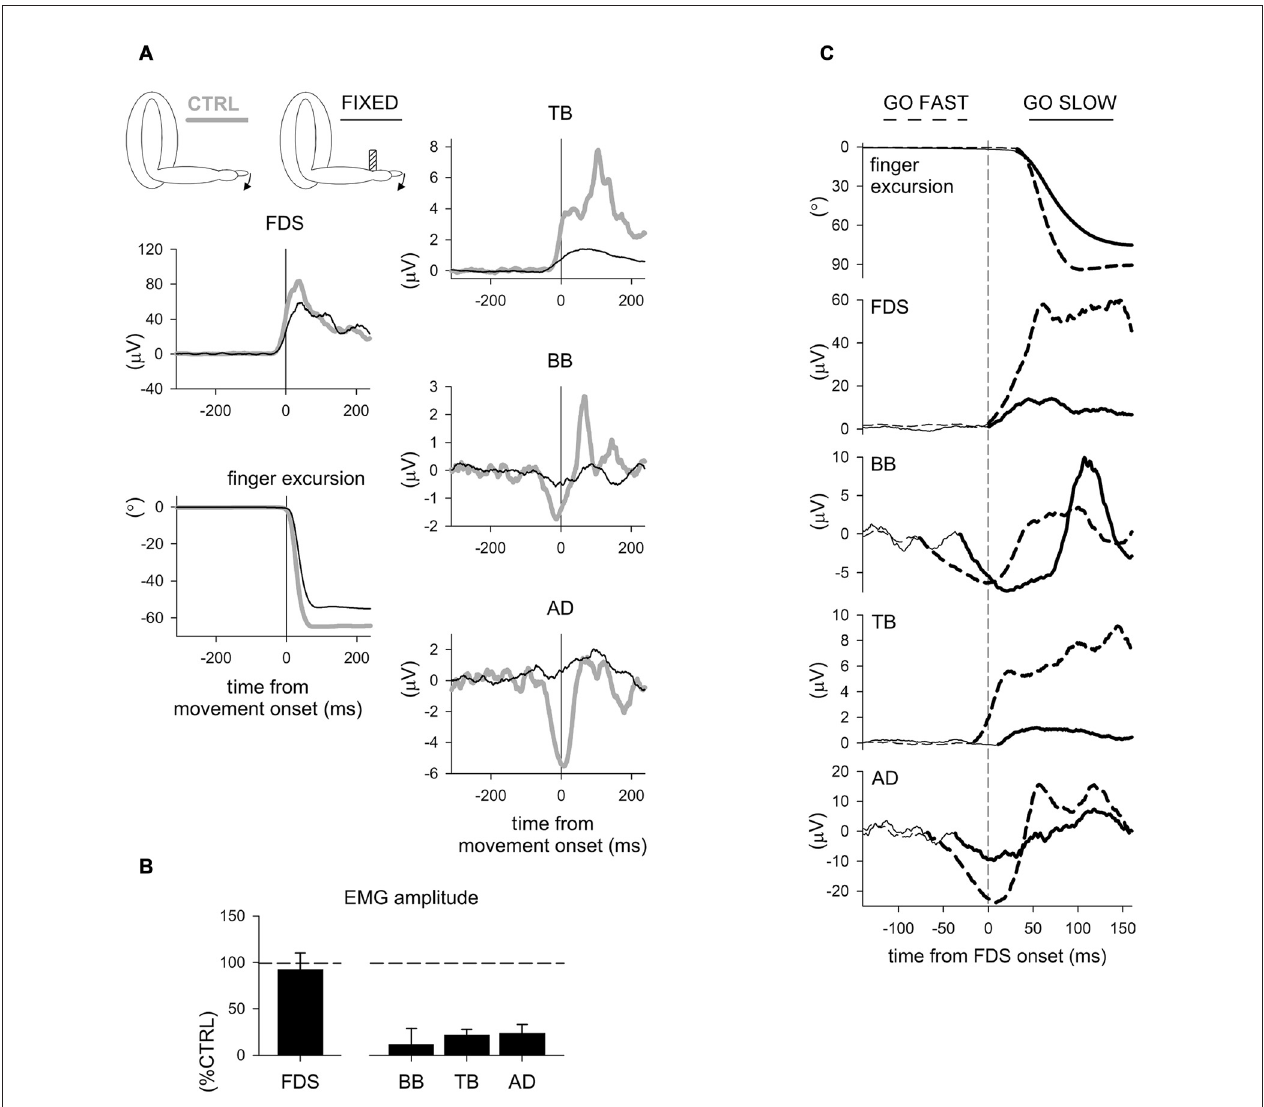
FIGURE 2 | Effects of fixation point and movement velocity on APAs. (A) Recordings of EMG activity in index-finger prime mover and intra-limb APAs in a representative subject, with or without a wrist fixation point. It is evident that both the EMG activity in the prime mover flexor digitorum superficialis (FDS) and the finger movement were comparable both with (FIXED, black) and without (CTRL, gray) the wrist fixation point, while in the FIXED condition APAs were deeply reduced in BB and TB and completely abolished in AD. (B) Mean amplitude of pre-movement FDS EMG and of APAs in BB, TB and AD. Values in % of the control sequence (CTRL). A t -test showed no CTRL vs. FIXED difference in FDS activation ( t 6 = 0.44, p = 0.67). The average inhibitory effects on BB and AD and excitation in TB revealed a significant reduction in the FIXED condition ( t 6 = 5.01, p = 0.002; t 6 = 12.41, p < 0.0001; t 6 = 7.80, p = 0.0002, respectively). Reproduced from